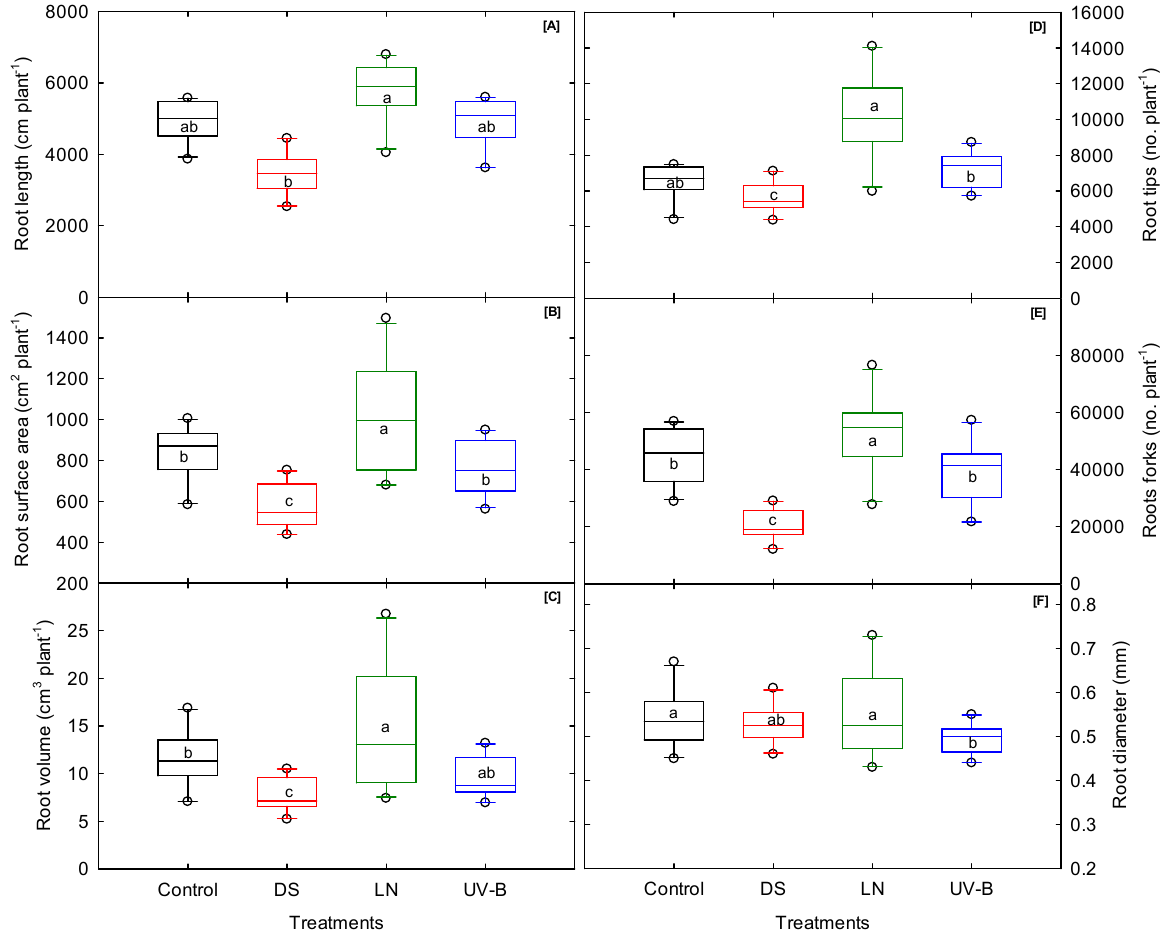
Figure 4. Drought (DS), low nitrogen (LN), and ultraviolet-B (UV-B) effect on ( A ) root length, ( B ) root surface area, ( C ) root volume, ( D ) root tips, ( E ) root forks, and ( F ) root diameter of 10 sweet potato cultivars measured at 20 days after planting. The middle line indicates the median, and the box shows the range of the 25th to 75th percentiles of the total data. The different alphabetic letters (a, b, and c) labeled within the box represent the significant differences between treatments (Duncan Multiple Range Test, p < 0.05), and the outer dots are outliers.